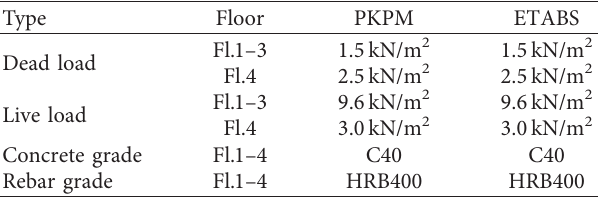
Figure 5: Single-span structural layout of a reinforced concrete frame structure. Table 2: Load and material information used in PKPM and ETABS.